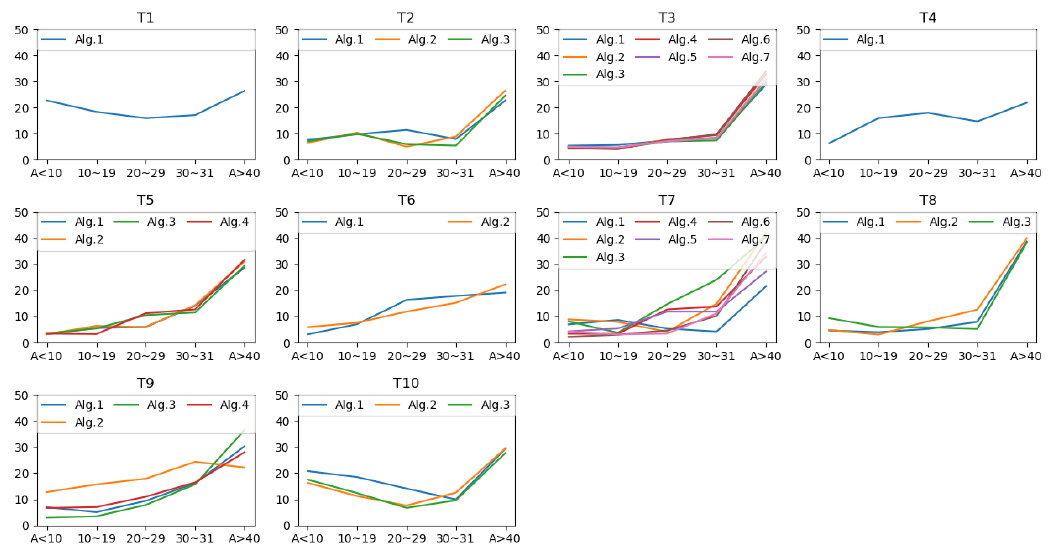
Figure 11. Age prediction results by age groups for the 10 teams.